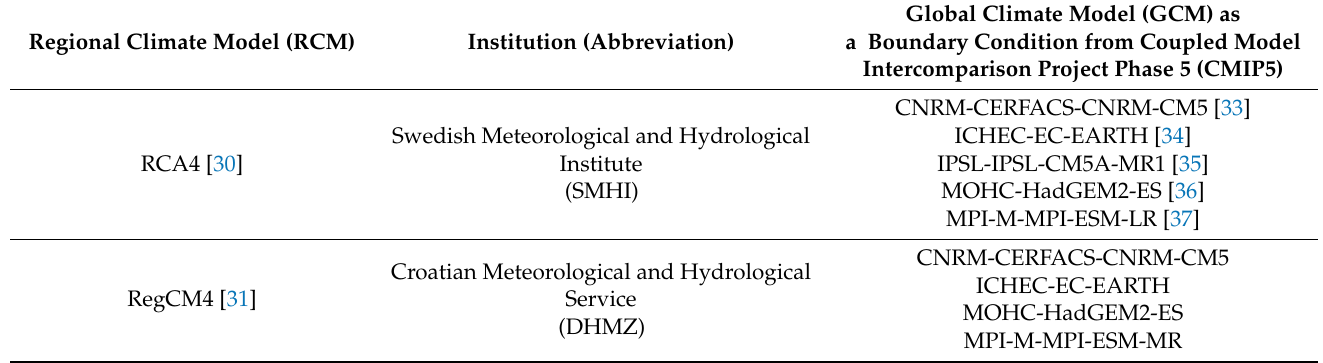
Table 1. Overview of the analyzed